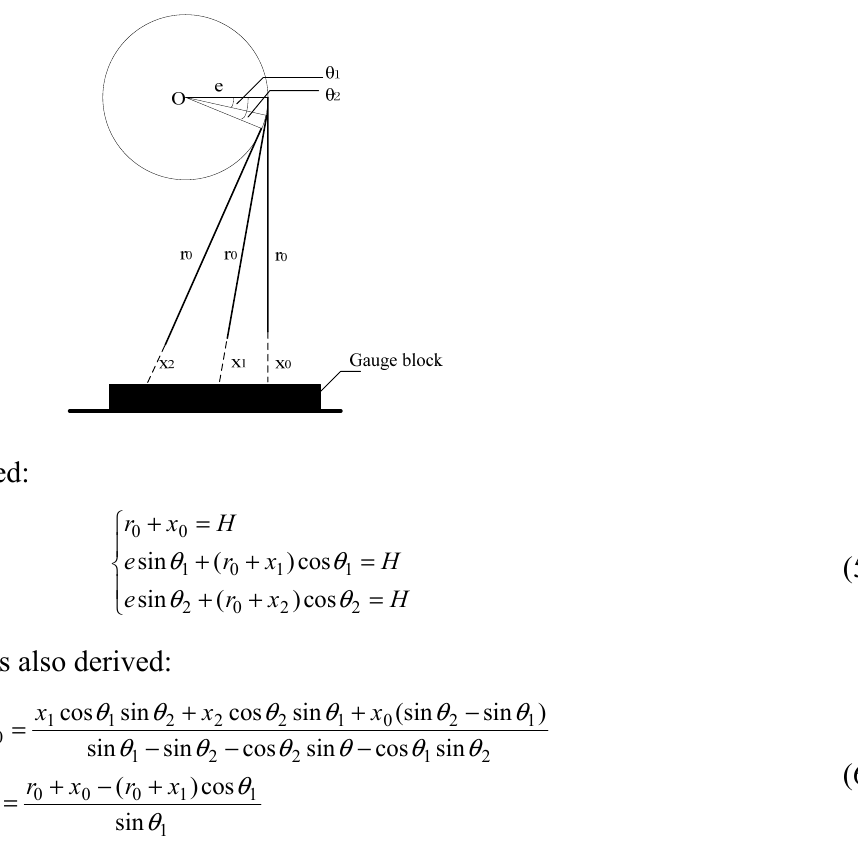
Figure 3. Calibration of offset systematic error.